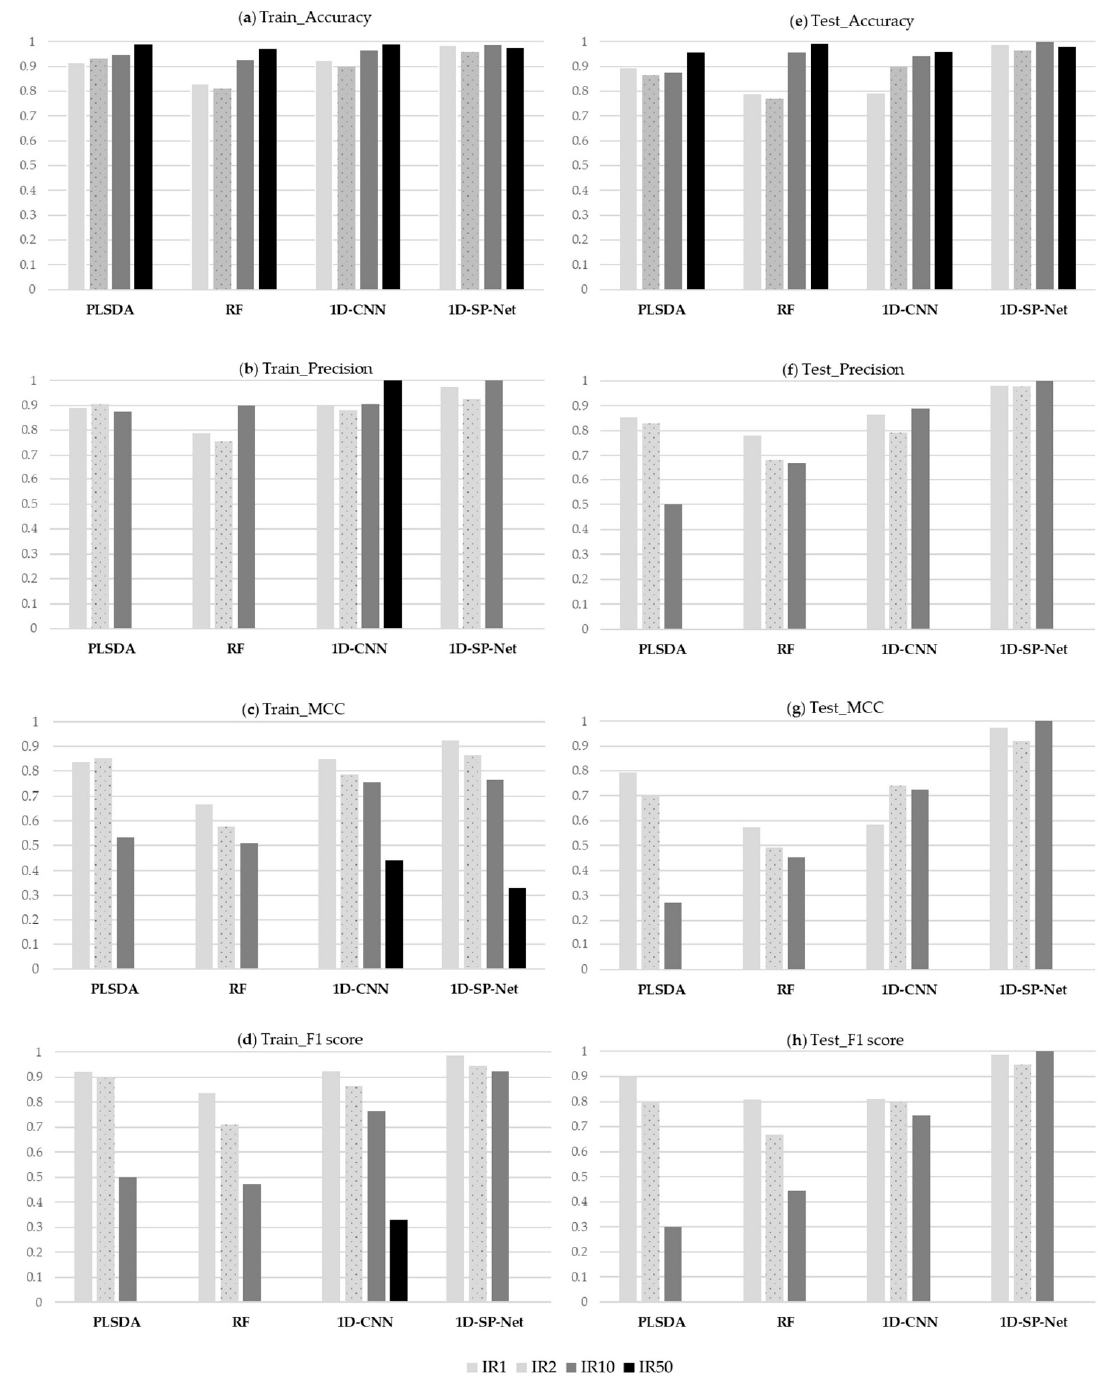
Figure 8. Evaluation of prediction performance for the PLSDA, RF, 1D-CNN, and 1D-SP-Net using data sets with imbalance ratios (IRs) equal to 1, 2, 10, and 50 by accuracy, precision, MCC, and F1 score at both the training and the testing stages: ( a ) training by accuracy; ( b ) training by precision; ( c ) training by MCC; ( d ) training by F1 score; ( e ) testing by accuracy; ( f ) testing by precision; ( g ) testing by MCC; ( h ) testing by F1 score.